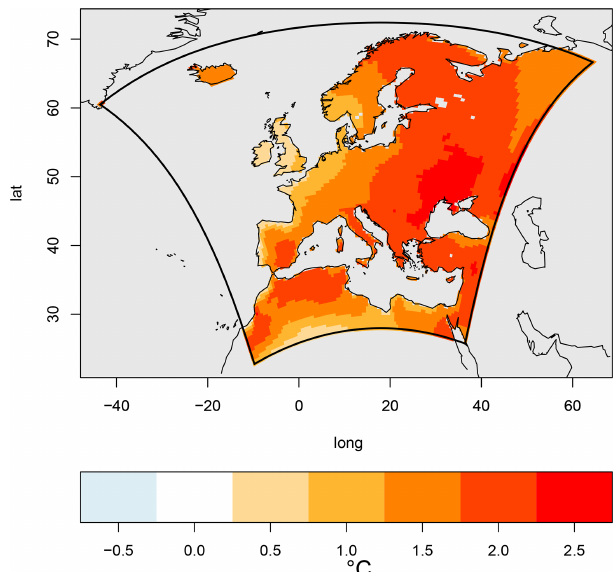
Figure 3. Mean of the anomalies of summer (JJA) mean near- surface temperature calculated between each of the ensemble re- alizations, subtracting to the climatological value of the mid- Holocene (MH) the one obtained for the pre-industrial period (PI).